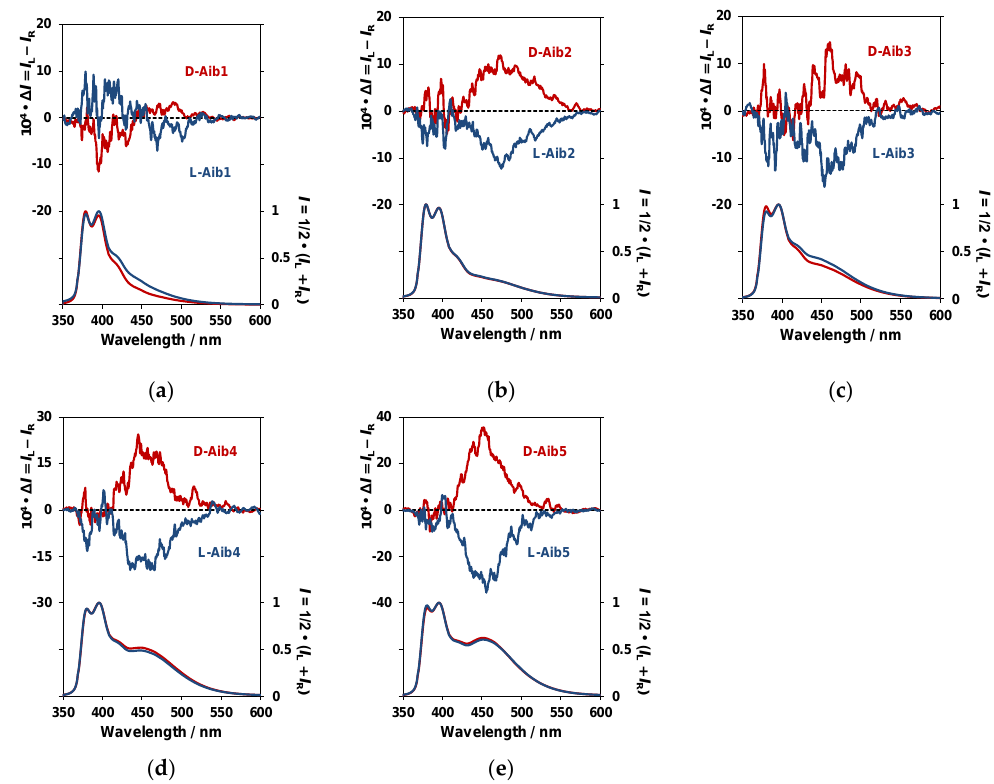
Figure 2. Circularly polarized luminescence (CPL) (upper panel) and photoluminescence (PL) (lower panel) spectra of ( a ) D -Aib1 / L -Aib1 ; ( b ) D -Aib2 / L -Aib2 ; ( c ) D -Aib3 / L -Aib3 ; ( d ) D -Aib4 / L -Aib4 ; and ( e ) D -Aib5 / L -Aib5 in CHCl 3 (1.0 × 10 −4 M). D -isomer and L -isomer spectra are shown in red and blue, respectively. Path length = 1